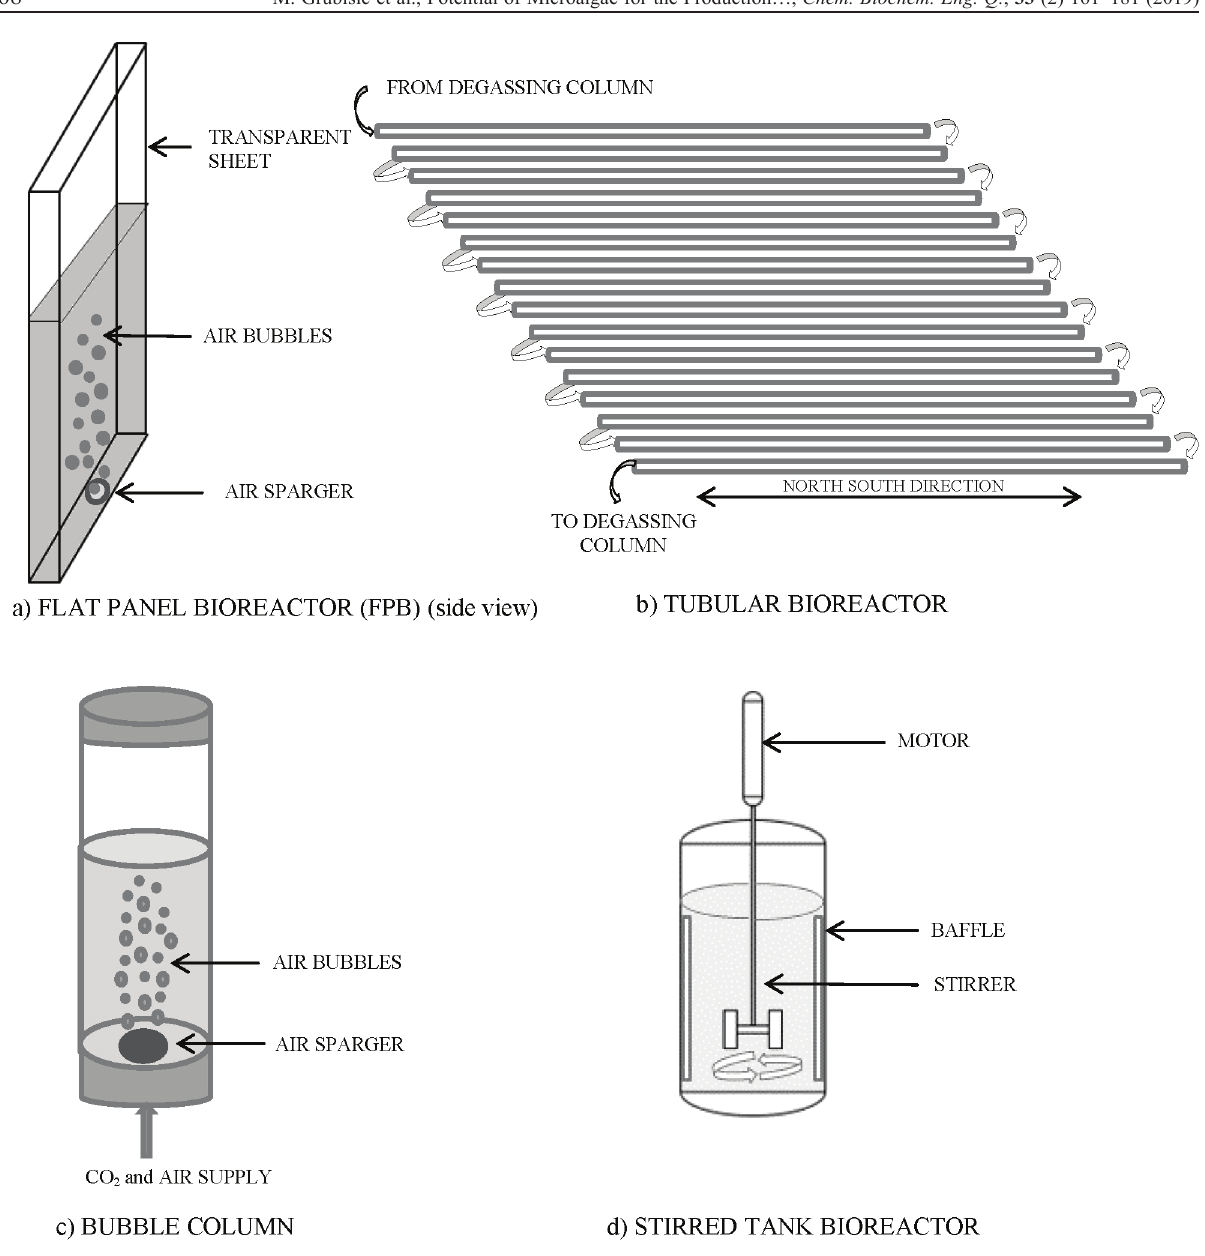
Fig. 2 – The most common photobioreactor designs (adapted from Gupta et al. 43